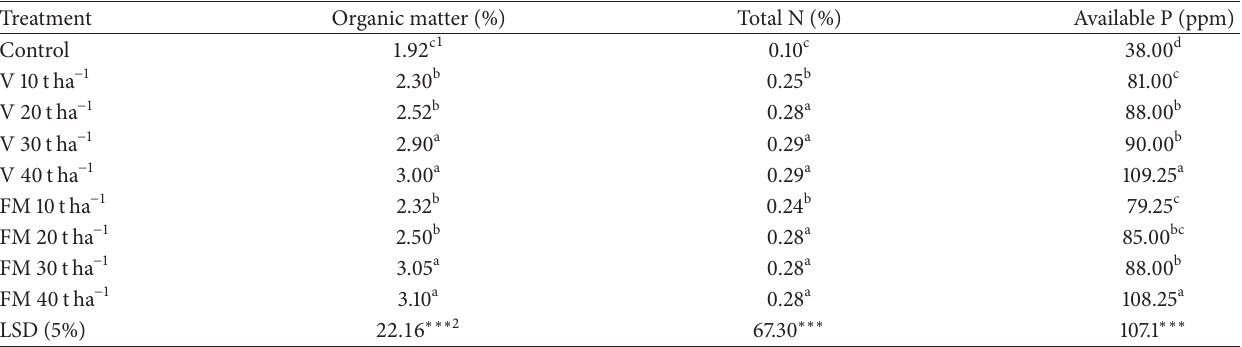
Table 2: Organic matter, total nitrogen, and available phosphorus contents of soils treated with vermicompost (V) and farmyard manure